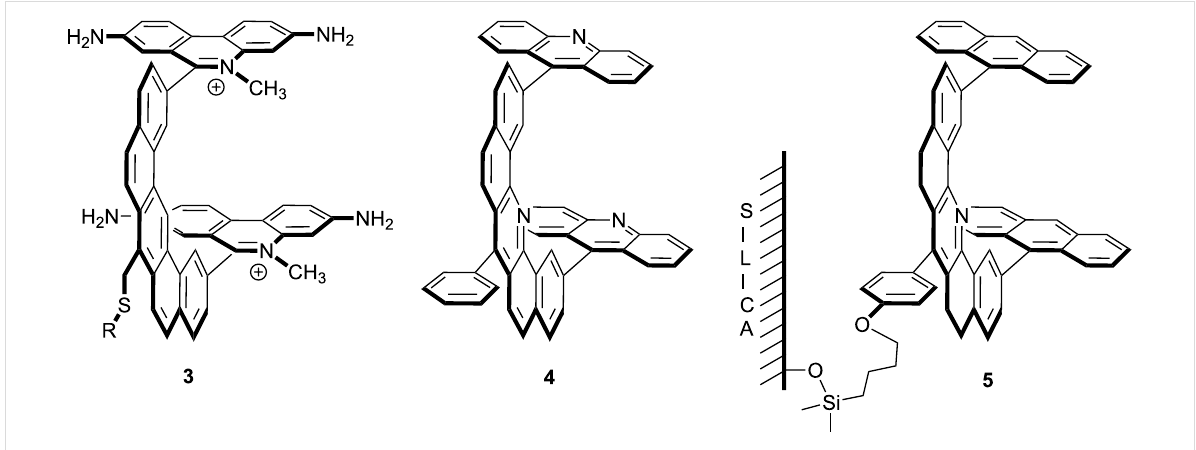
Figure 3: Bismethidium molecular tweezer 3 proposed as a graduate student at Columbia University, which was quite close in structure to 4 , synthe- sized and studied at Illinois. Chemically bonded stationary phase 5 used for HPLC assay of nitrated aromatics and for quantitative enthalpy determi-